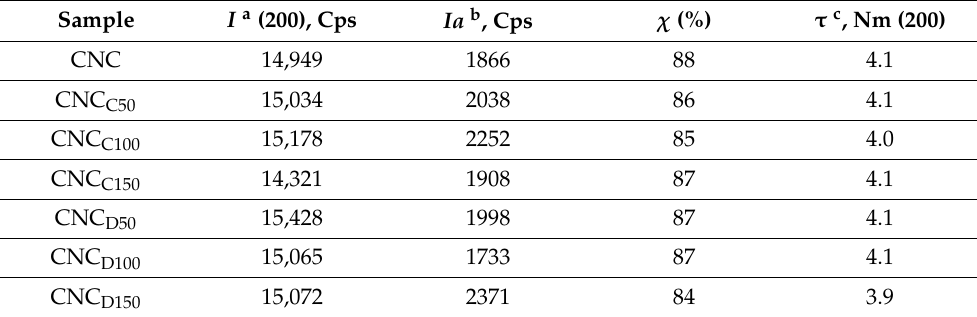
Table 3. Crystallographic parameters of CNCs and m